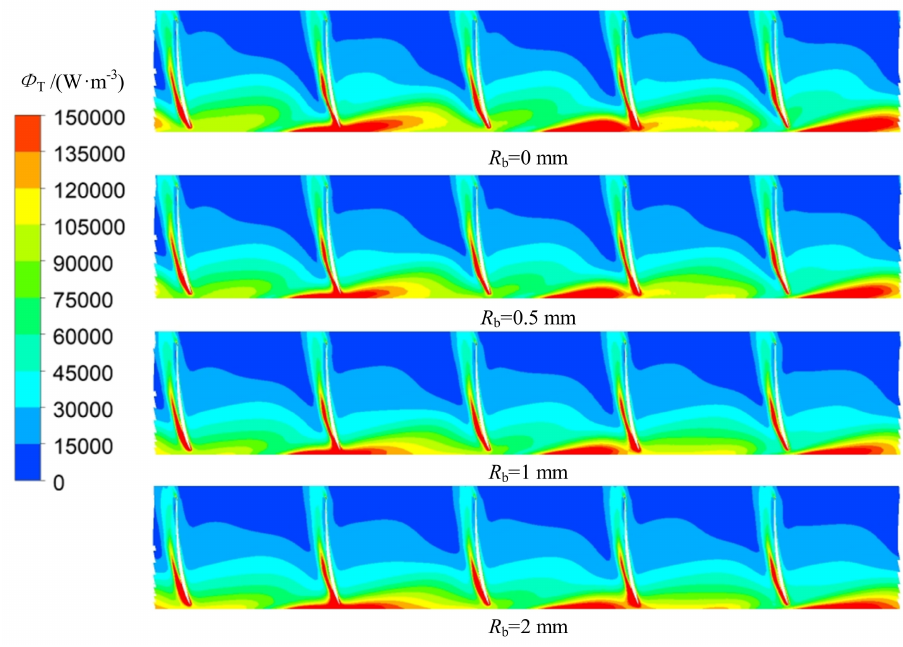
Figure 17. Distribution of total dissipation rate in cylindrical section of guide vane under different R b at 1.0 Q des ( Span = 0.97).